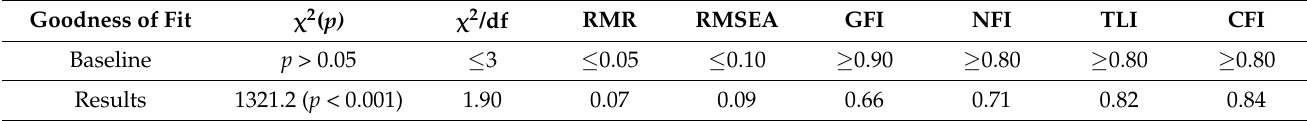
Table 4. Model fit of the SSNER-SL ( n =